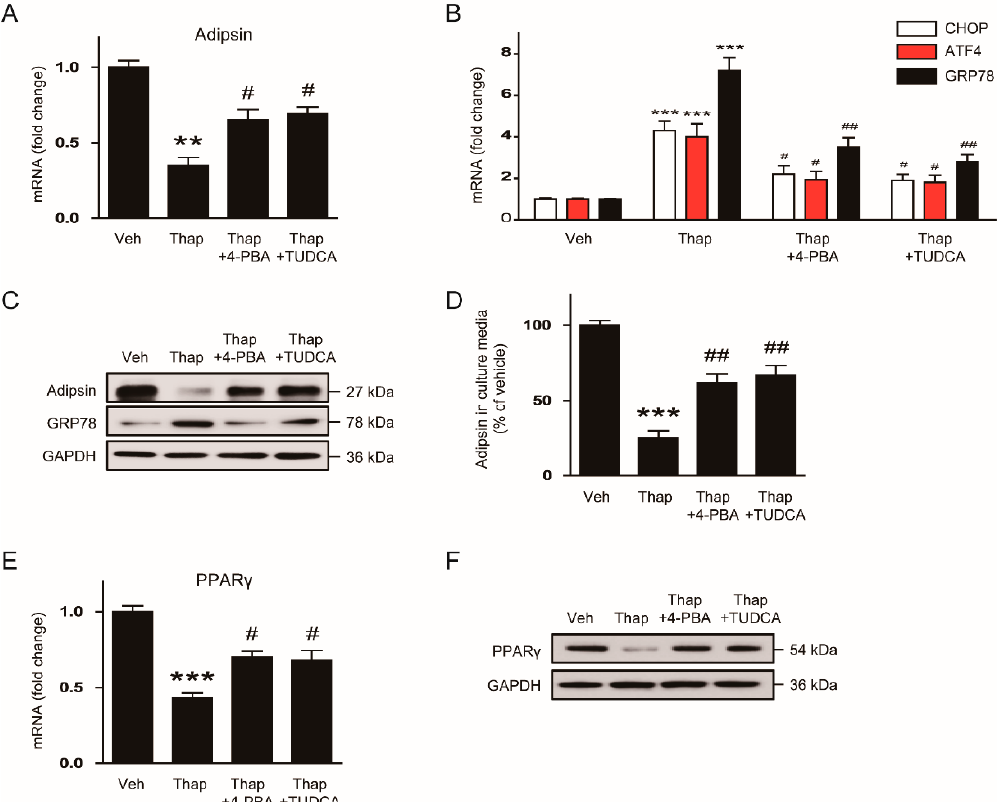
Figure 6. Chemical chaperones reverse the ER stress-mediated downregulation of adipsin in vitro. After pretreatment with 4-phenylbutyric acid (4-PBA; 10mM) or tauroursodeoxycholic acid (TUDCA; 0.5 mM) for 30 min, mature 3T3-L1 adipocytes were incubated with vehicle (Veh; DMSO) or thapsigargin (Thap; 10 nM) for 24 h. ( A ) Real-time RT-PCR analysis of adipsin. ( B ) Real-time RT-PCR analysis of CHOP, ATF, GRP78. ( C ) Western blot analysis of adipsin, GRP78, and GAPDH. GAPDH was used as a loading control. ( D ) Levels of adipsin secreted from the cells into culture media. ( E ) Real-time RT-PCR analysis of PPAR γ . ( F ) Western blot analysis of PPAR γ and GAPDH. GAPDH was used as a loading control. All data are represented as the mean ± SEM. ** p < 0.01 and *** p < 0.001 vs. Veh-treated cells. # p < 0.05 and ## p < 0.01 vs. Thap-treated cells.